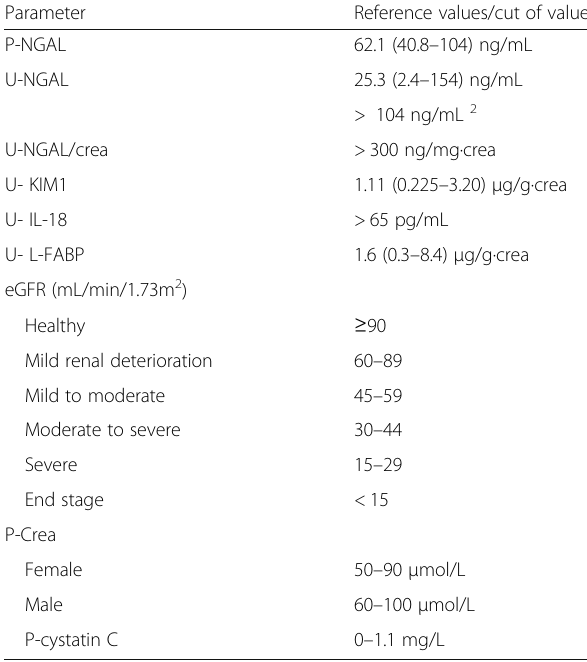
Table 1 Reference values for kidney injury biomarkers. Data are given as mean (minimum- maximum) or cut-off